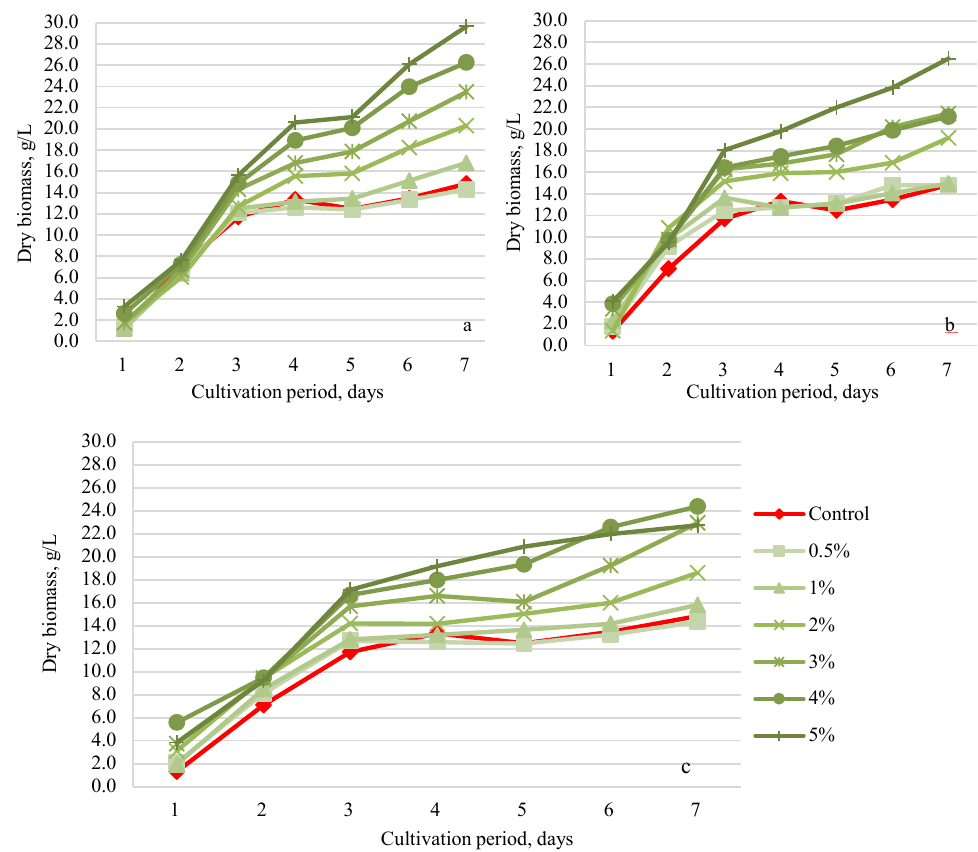
Fig. 1. R. glutinis biomass weight during cultivation period for samples with 0.5 %, 1–5 % concentration: a) Tween 20; b) Tween 40; c) Tween 80 supplementation compared with control without